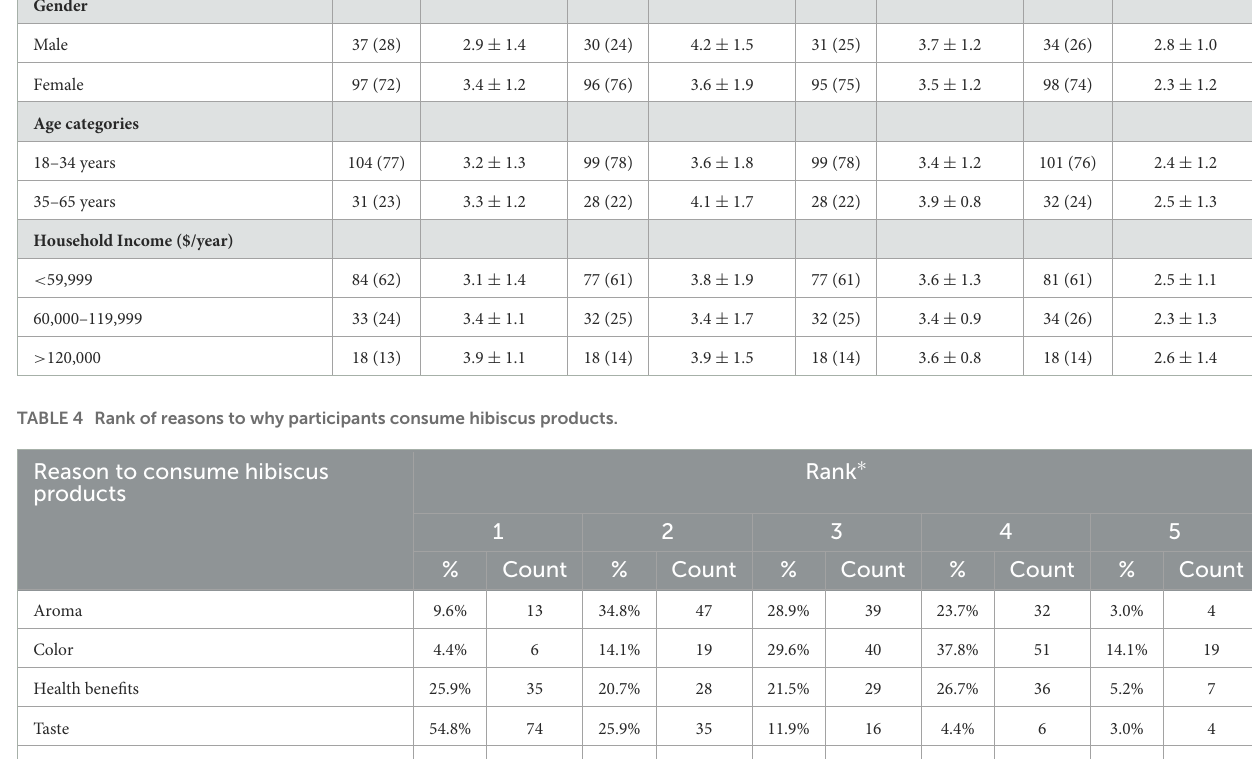
TABLE 3 Likeability of hibiscus beverage (juice, kombucha, smoothies, and teas) while considering demographic categories (age, gender, income). Characteristics